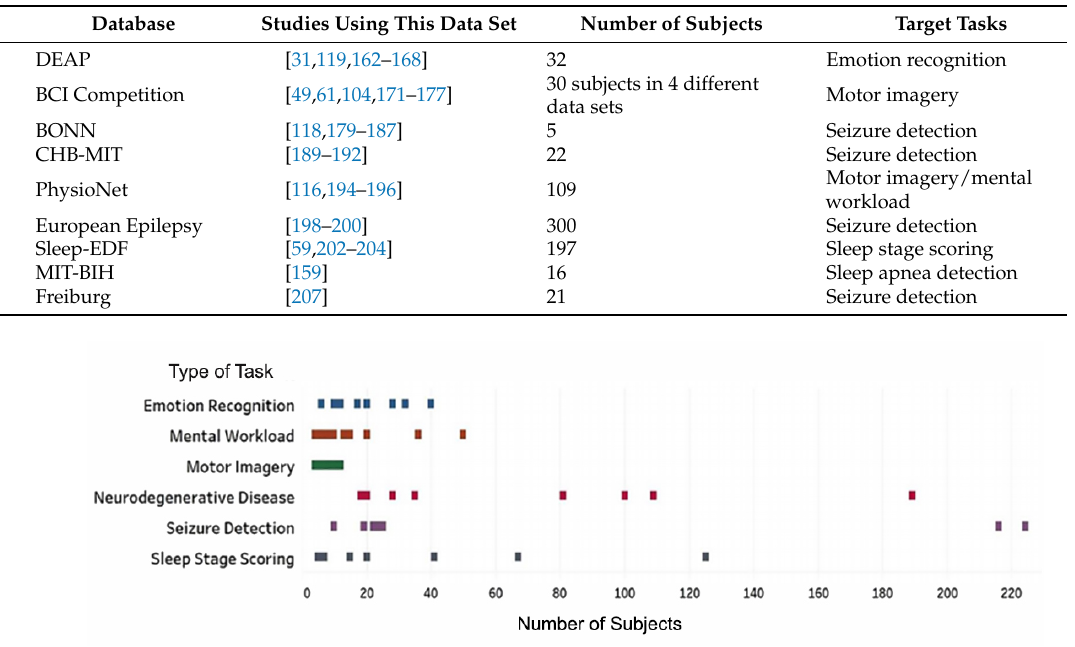
Table 2. List of public data sets used for the analysis of EEGs associated with different types of tasks.